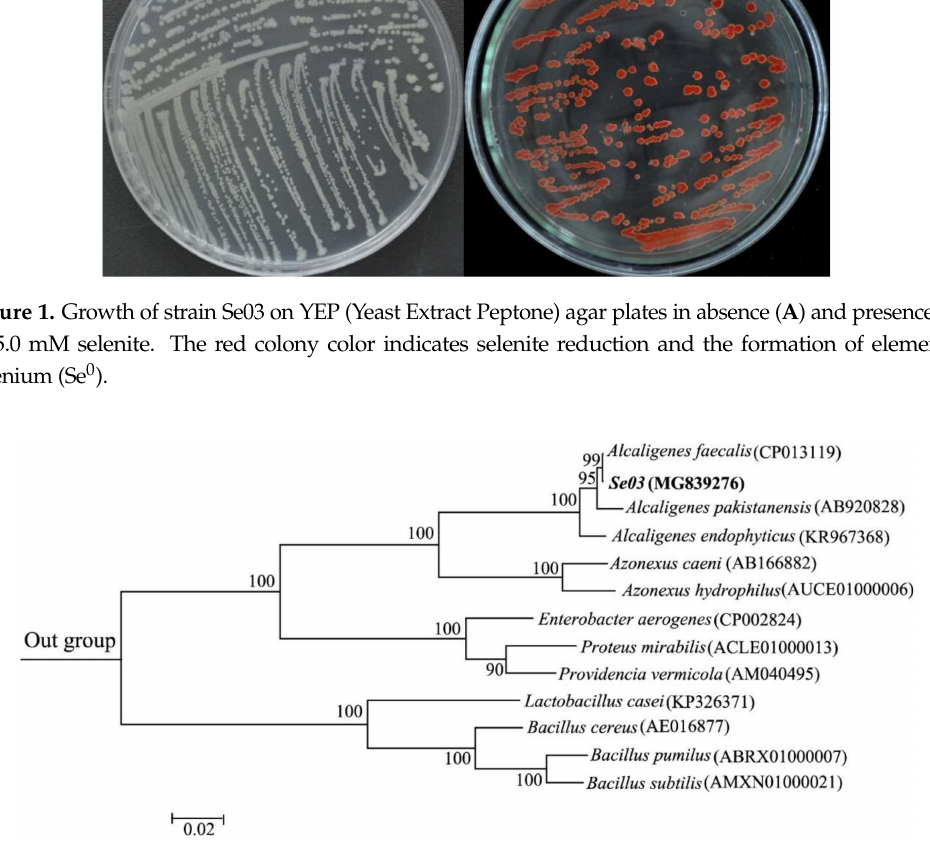
Figure 2. Maximum likelihood tree based on the 16S rRNA gene sequence of isolate Se03 and the sequences of representative strains from GenBank. The scale bars indicate 0.02 substitutions per site. Sphingobacterium zeae (KU201960) was used as an